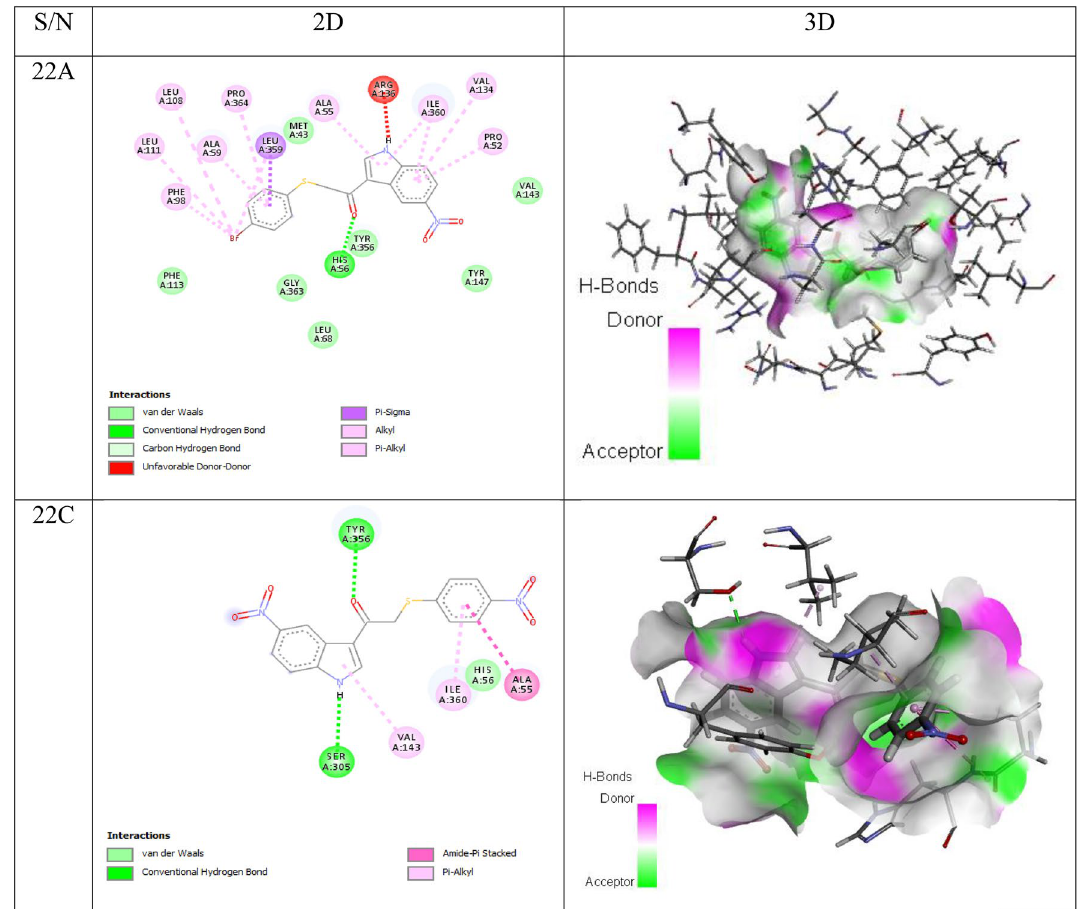
Fig. 5 2D and 3D docking poses showing interactions of compounds 22A and 22C in the binding sites of